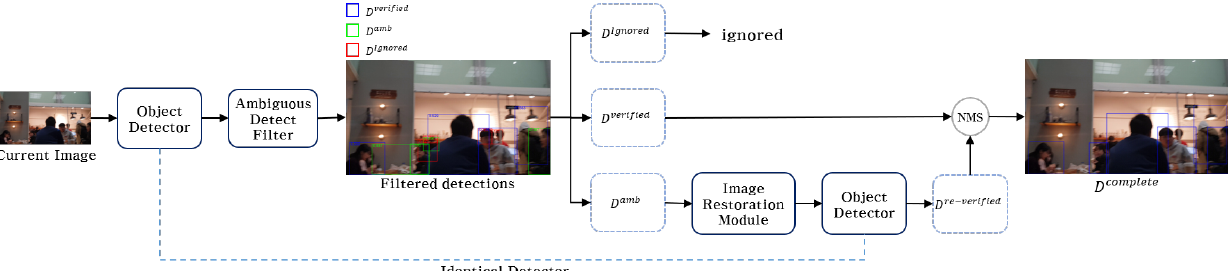
Figure 2. Schematic representation of the proposed re-detection method. It illustrates how the re-detection method works according to the data